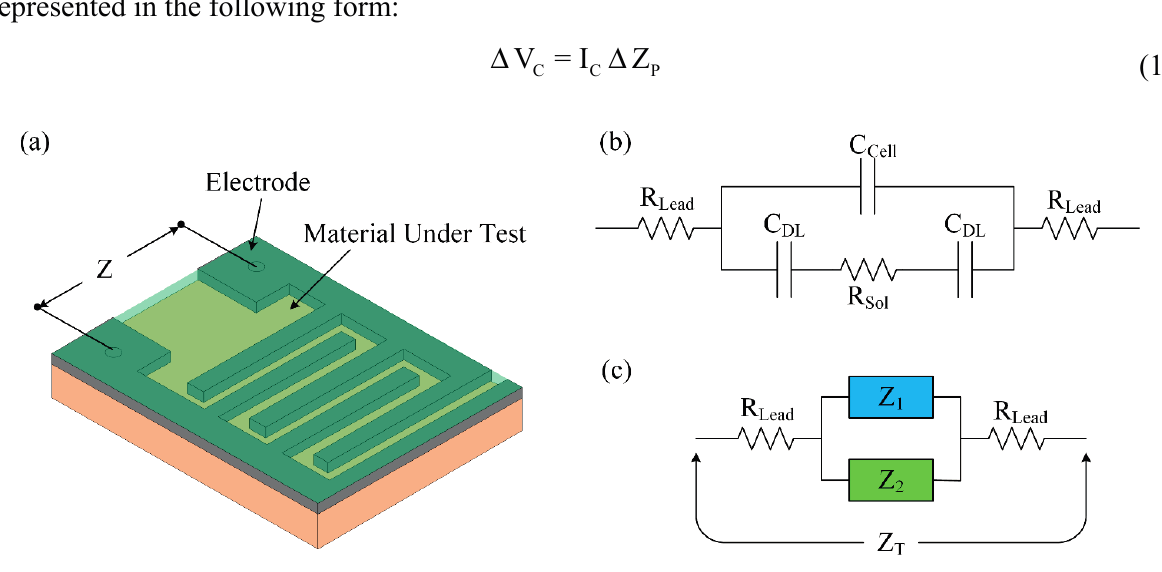
Figure 2. Interdigitated electrode: ( a ) configuration of the interdigitated impedance cell; ( b ) simplified electrical circuit of the interdigitated impedance cell; and ( c ) analogy of Figure